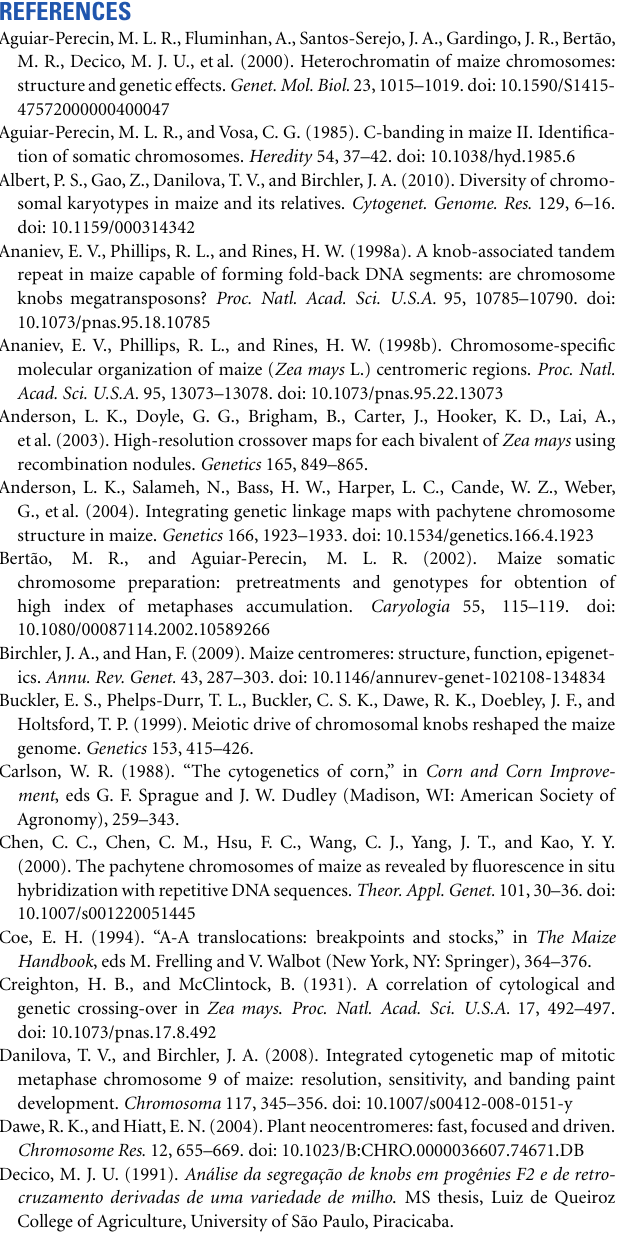
Figure S1 | Origin and C-band (knob) composition of the S6 inbred line families JD 1-3 and JD 4-4 derived from a S2 progenitor, which segregated for knobs on 3L, 5L, 7S, and 9S and was homozygous for knobs on 6L, 7L, and 8L. Figure S2 | CentC probe consisting of two CentC consensus repeats (Ananiev etal., 1998b) of 139-bp and 154-bp respectively